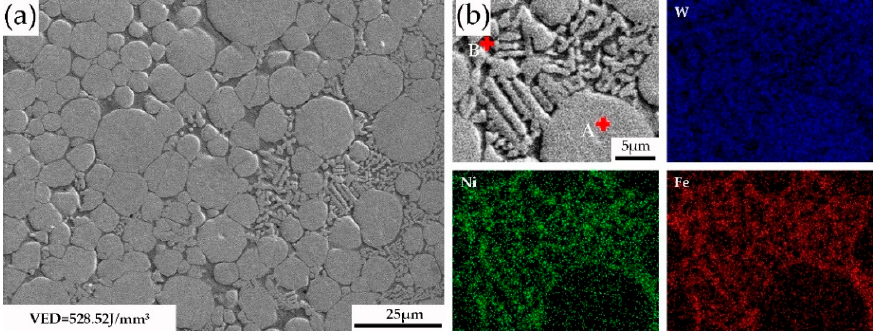
Figure 12. ( a ) The microstructure of 90W ‐ 7Ni ‐ 3Fe under VED = 518.52 J/mm 3 ; ( b ) element distribution.